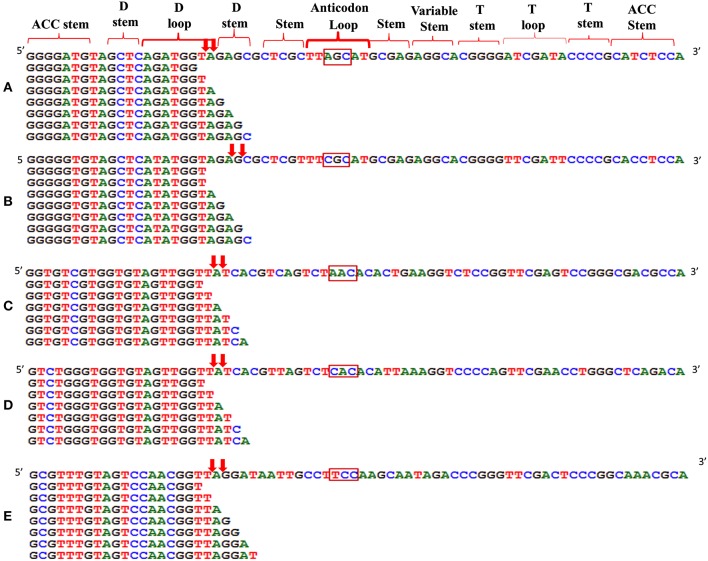
Alignment of 5′tRF isoforms to the mature tRNAs of (A) Ala-tRNAAGC, (B) Ala-tRNACGC, (C) Val-tRNAAAC, (D) Val-tRNACAC, and (E) Gly-tRNATCC. The cleavage sites were designated as downward arrows. The anticodon of each tRNAs was represented in the rectangle. The cleavage occurs at the D stem/loop region in the tRNAs.